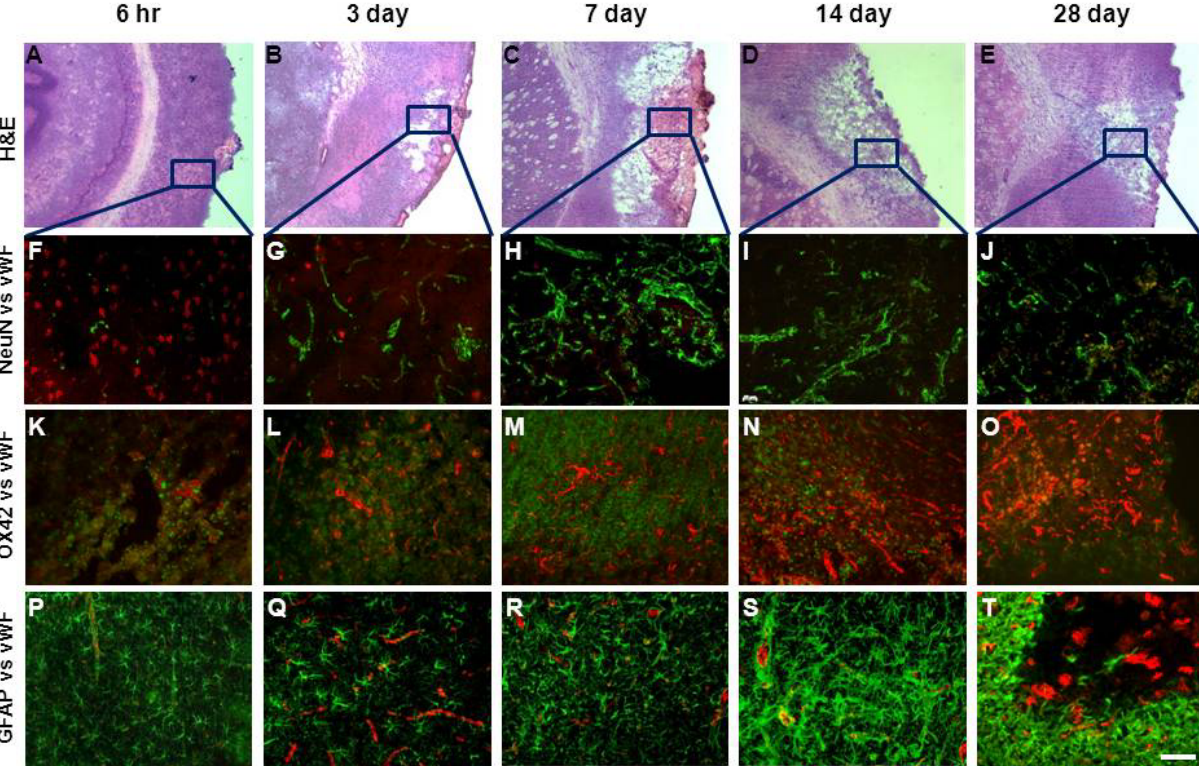
Figure 3. Angiogenesis and lesion pathology following ET-1 induced stroke. Hematoxylin and Eosin (H & E) stained images of the infarcted cortex between 6 h and 28 days post-stroke ( A – E ) were used to identify areas of interest for vWF, NeuN and OX42 histological analysis (as marked by frames). Merged immunofluorescent images of NeuN labeled neurons (red) and vWF labeled blood vessels (green) throughout the stroke affected cortex 6 h to 28 days after ET-1 induced stroke ( F – J ). Increased angiogenesis occurs in areas where there is greatest neuronal loss. Merged immunofluorescent images of vWF labelled blood vessels (red) with markers for microglia (OX42, green) ( K – O ); and astrocytes (GFAP, green) ( P – T ), 3, 7, 14 and 28 days post-stroke. Peak microglia activation occurs between 3 and 7 days whilst activated astrocytes are observed 3 days after stroke surrounding the damaged territory with intense staining detected by 14 days ( S ) that infiltrates into the core by 28 days ( T ). Scale bar = 100 μ